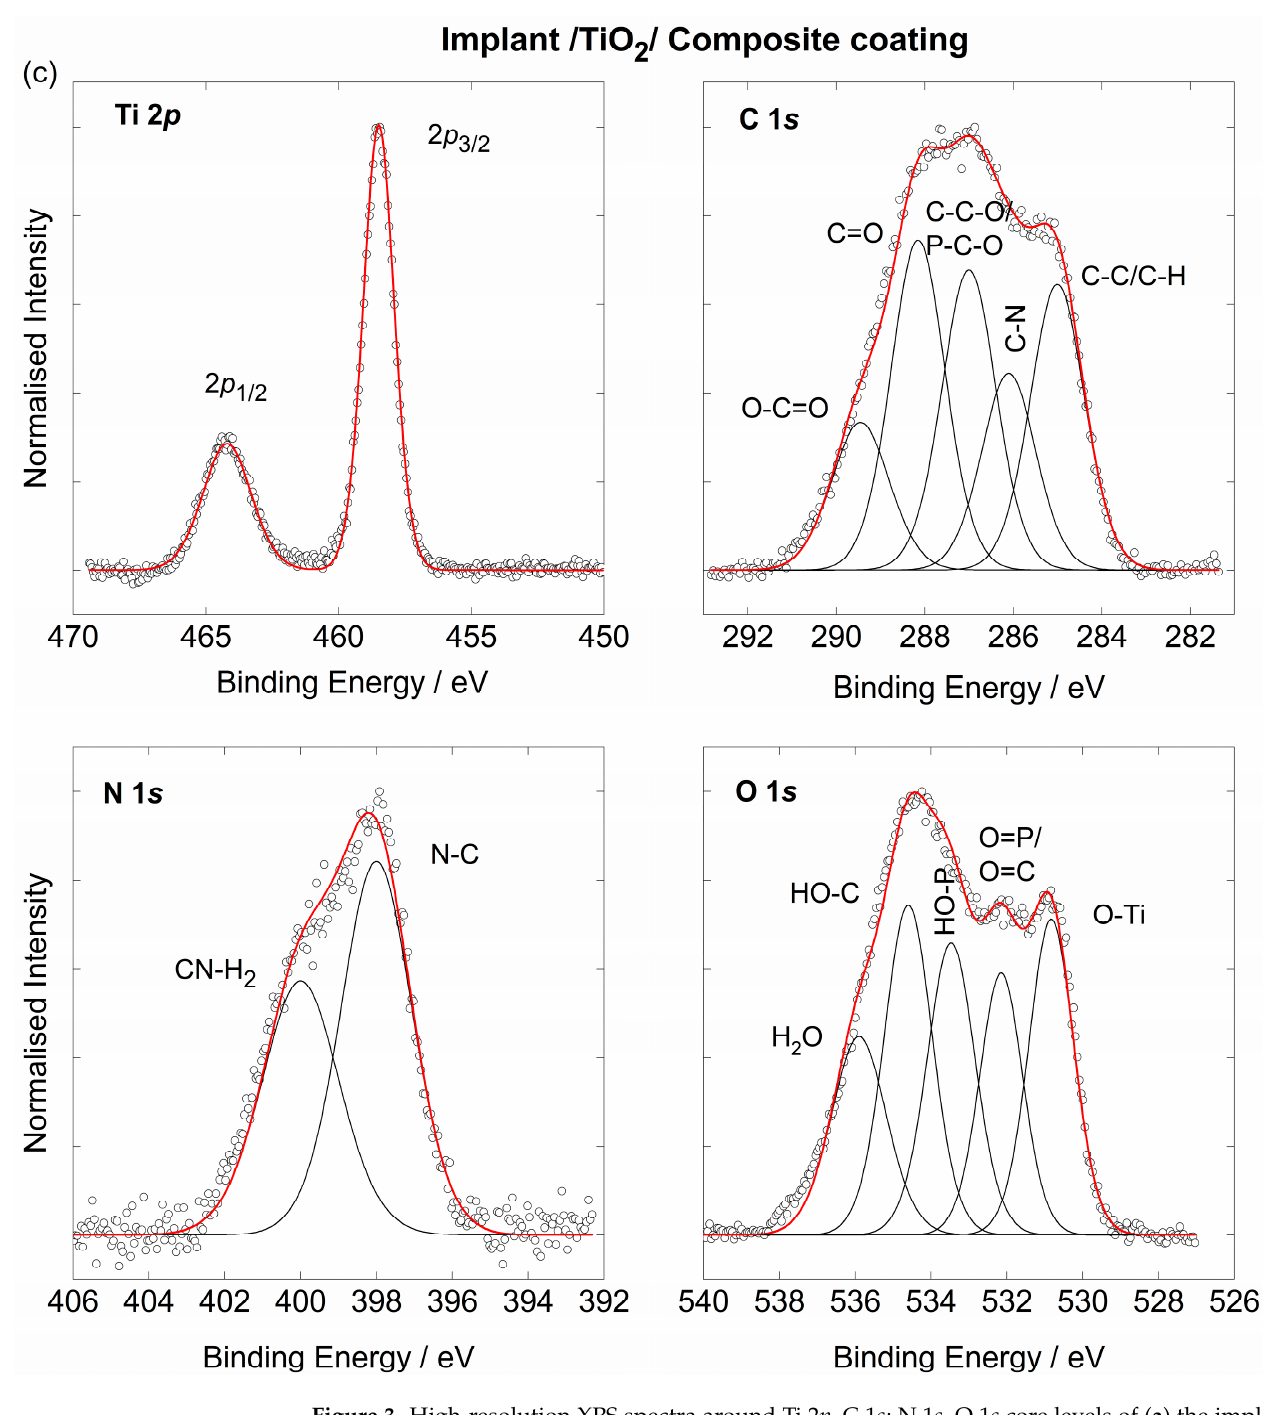
Figure 3. High-resolution XPS spectra around Ti 2 p , C 1 s ; N 1 s , O 1 s core levels of ( a ) the implant functionalised with alendronate [13], ( b ) the implant functionalised with hydrolysed collagen, and ( c ) the implant functionalised with composite coating. Symbols: experimental data; black lines: main contributions; red line: total fit; *: contamination.